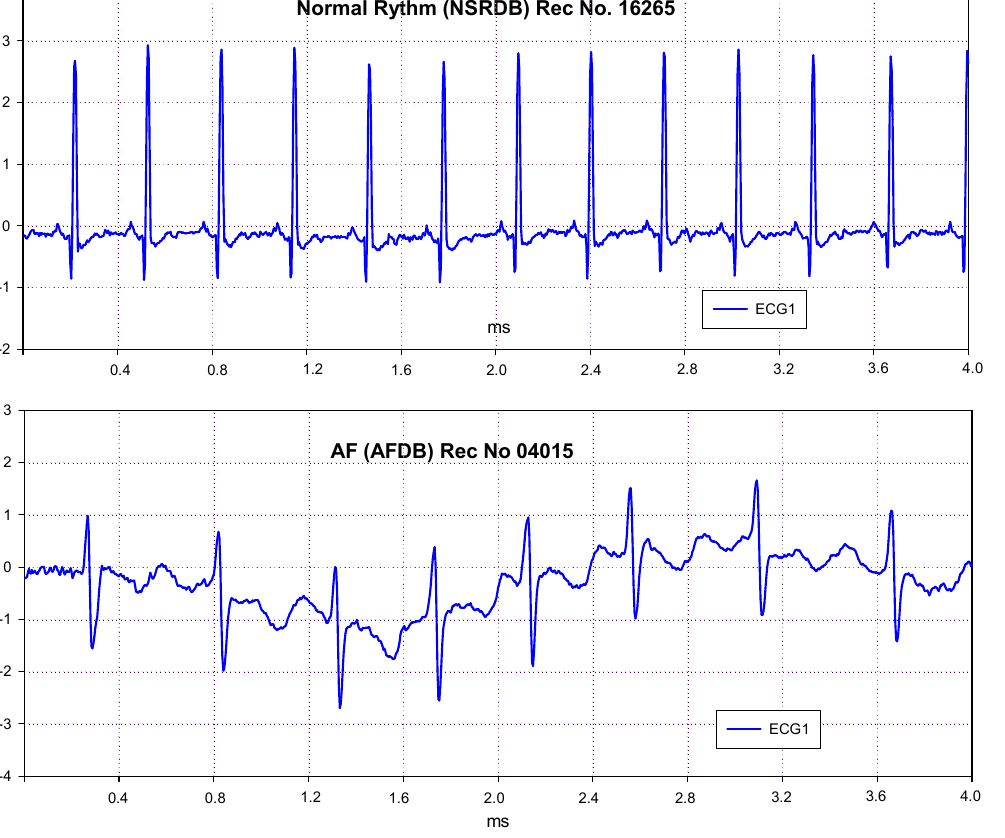
Algorithm 1. Feature Extraction Algorithm.